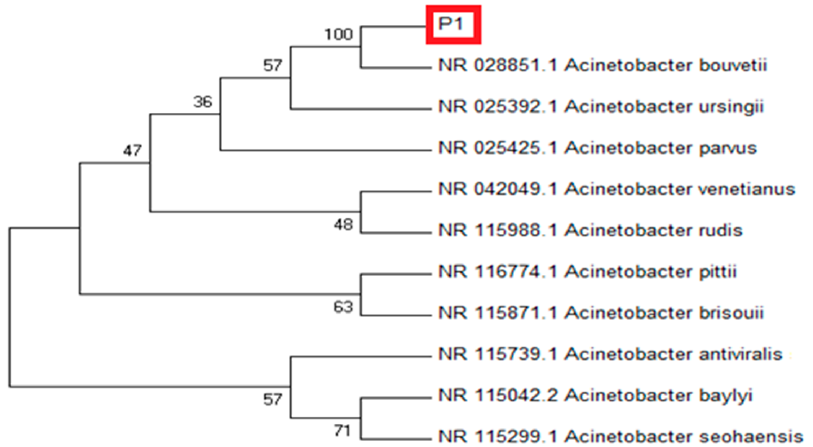
Figure 1. Molecular phylogenetic analysis of rhizobacterial strain P1 (red frame) showing evolution- ary relationships of taxa using NJ (Neighbor Joining) tree method. The analysis of the evolutionary relationship was carried out in MEGA7 using 16 S rDNA sequences of our isolate and closely related sequences retrieved from NCBI GenBank. Nodes are labeled with bootstrap